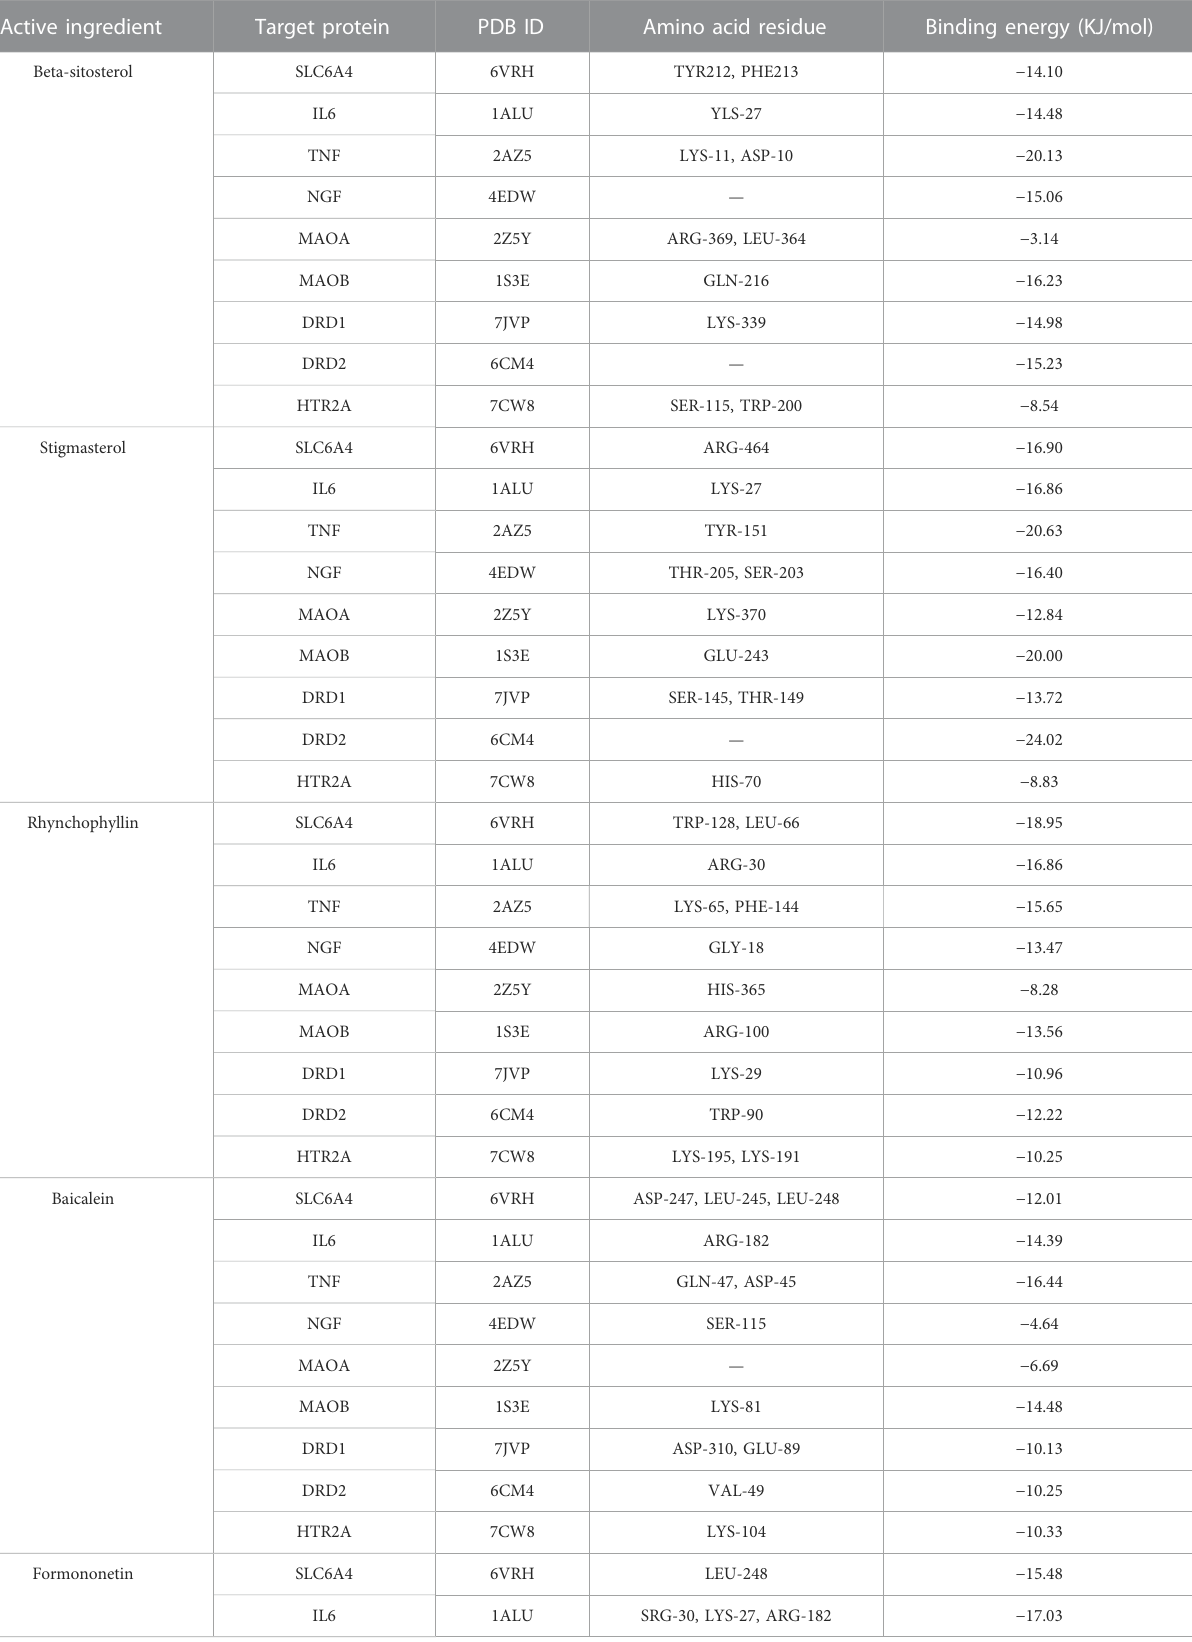
TABLE 6 The binding energy of key active ingredients docked with target